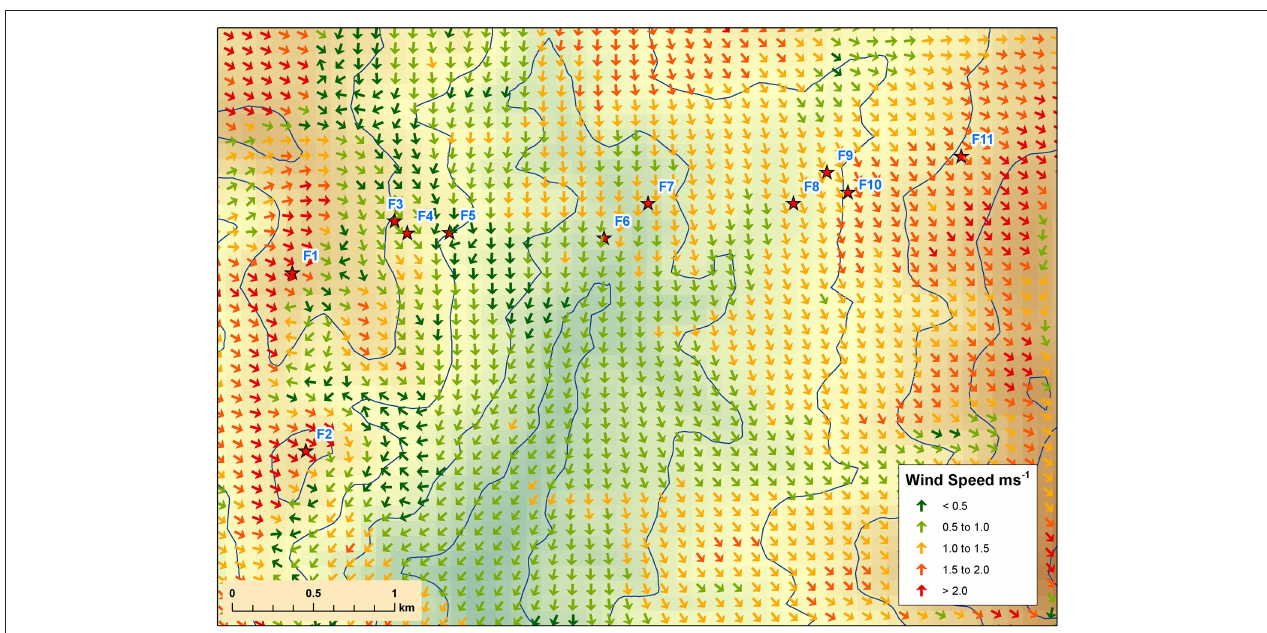
Table 3 are shown in green for WindNinja with the native solver, and red for WindNinja with the momentum solver. Table 4 gives